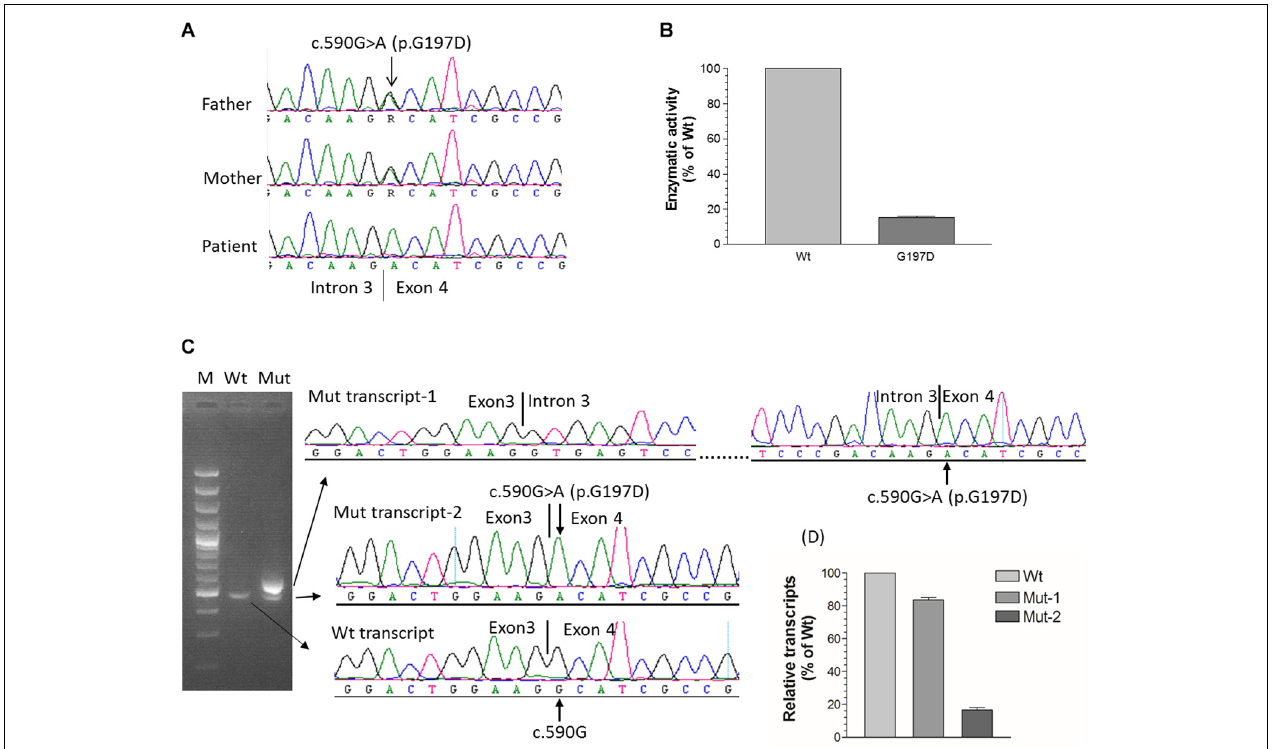
FIGURE 2 | Functional characterization of c.590G > A (p.G197D) mutation. (A) The homozygous c.590G > A mutation in patient 6 from family 4, which is located at the first nucleotide of exon 4. Her parents carry a heterozygous mutation. (B) 1 α -hydroxylase activity in CHO cells expressing wild-type and G197D CYP27B1 cDNA. Enzymatic activity of G197D is expressed as a percentage of wild-type enzyme. The mutant retained 16% of wild-type1 α -hydroxylase activity. (C) Impact of c.590G > A on pre-mRNA splicing by CYP27B1 mini-gene analysis. Both wild-type and mutant constructs were transfected into Hek293 cells for CYP27B1 mini-gene expression. RNA was isolated and reversed-transcribed to cDNA for RT-PCR and sequence analysis. The c.590G > A mutation leads to two populations of transcripts: retention of intron 3 (83% of transcripts from Mut-1) and correctly spliced transcripts (17% of transcripts from Mut-2). (D) Quantification of band intensity. The band intensity of (C) was quantified using ImageJ (https://imagej.nih.gov/ij/). Data are expressed as mean ±